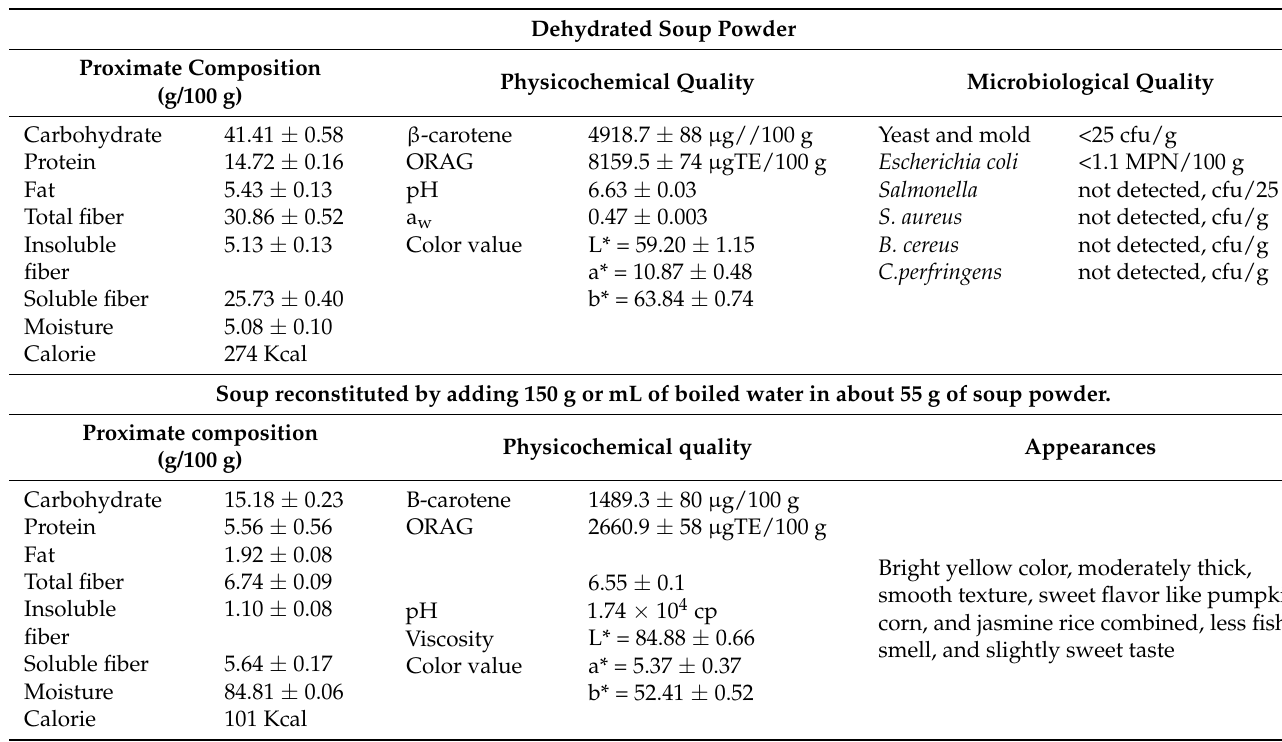
Table 5. Proximate, physicochemical, and microbiological quality of dehydrated soup powder and reconstituted soup for the elderly.